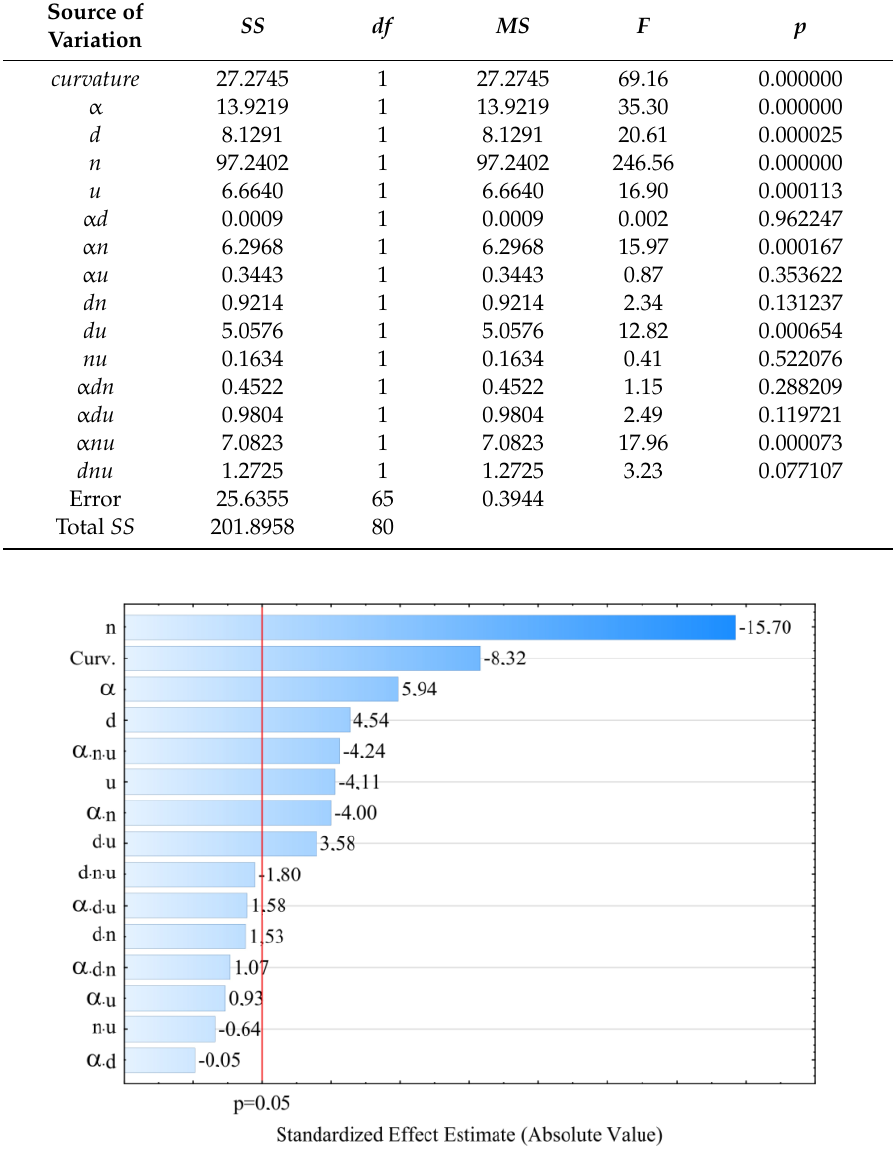
Table 3. Model of tensile strength σ –ANOVA table. R 2 = 0.87; R adj2 = 0.84 (markers as in Table 2).